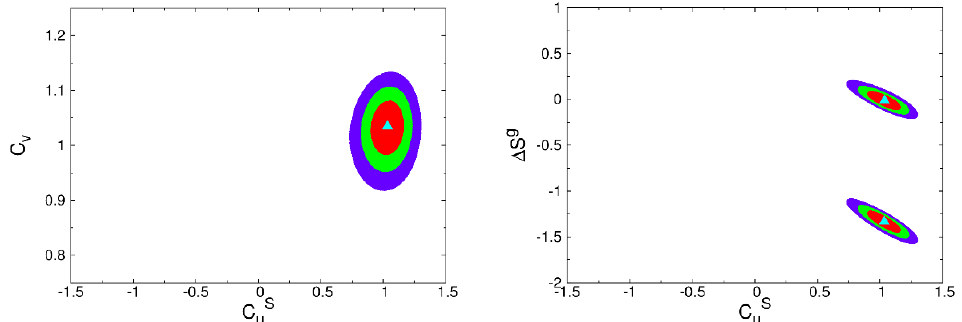
Figure 10 . CPCX3 : the con(cid:12)dence-level regions of the (cid:12)t by varying C v , C S code is the same as in (cid:12)gure